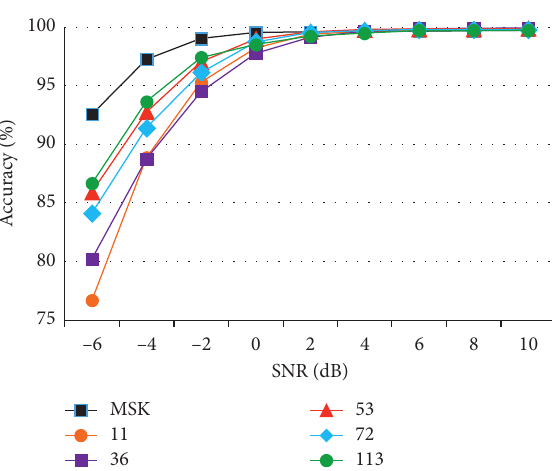
Figure 4: Diagnosis accuracy of the multiscale CNN and single CNN